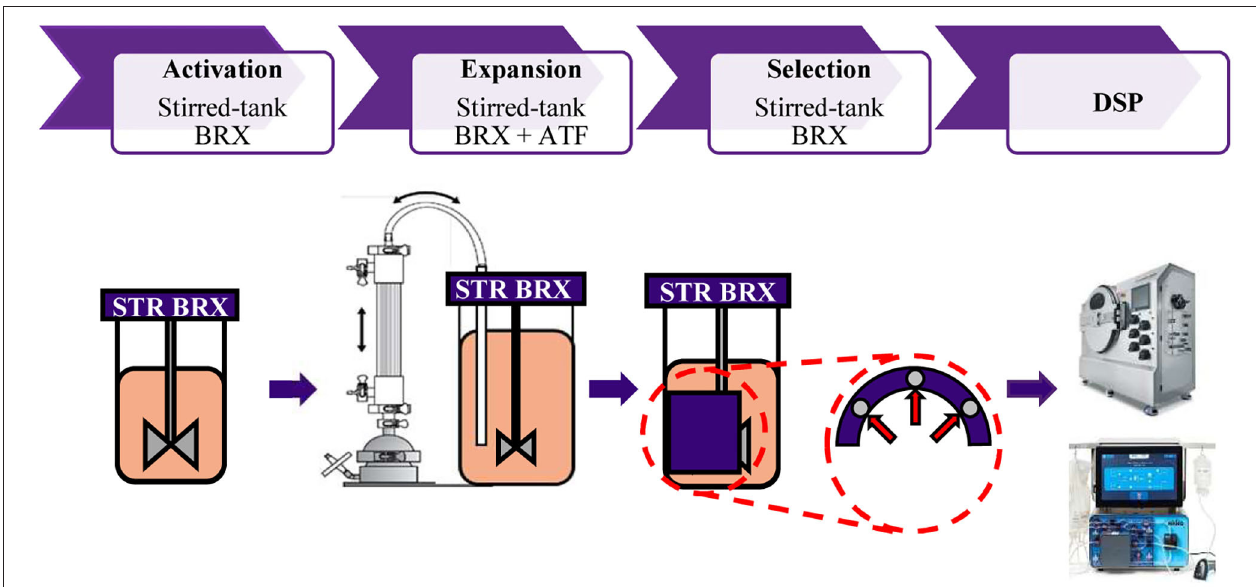
FIGURE 6 | Representation of closed, GMP compatible end-to-end platform for activation, expansion, selection and downstream processing of T cells. T cell activation is performed in the STR. Cell retention and continuous media perfusion is enabled by ATF. Depletion of undesired cells is performed in the STR with proprietary magnetic technology. Cells are concentrated and formulated using automated closed